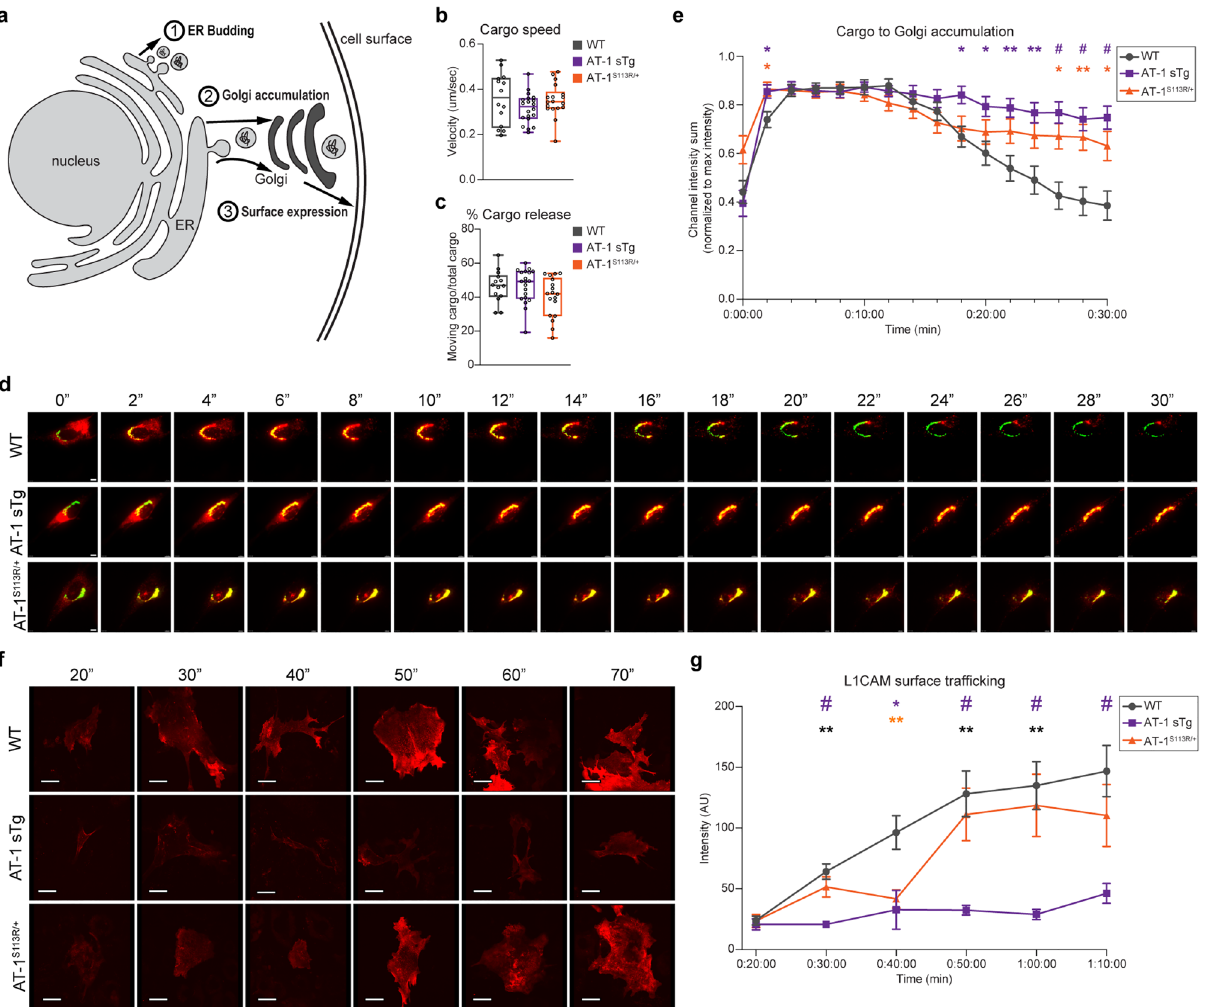
Figure 3. Aberrant AT-1 models demonstrate altered protein trafficking through the secretory pathway. ( a ) Schematic of three experiments used to assess protein trafficking in the secretory pathway. Experiment 1 assesses protein-laden carriers following release from the ER; solubilizer-dependent cargo fluoresces for visualization. Experiment 2 quantifies the time for ER cargo to accumulate in the Golgi apparatus and then egress; solubilizer-dependent DsRed cargo traffics to GFP-labeled Golgi. Experiment 3 quantifies the time for ER cargo to reach the cell surface; solubilizer-dependent cargo with a HaloTag ligand is tracked for 70 min with HaloTag cell impermeable dye added prior to imaging. ( b,c ) Maximum speed of cargo release ( b ), and the percentage of cargo release ( c ), are tracked for 3 min after solubilizer induced cargo release in MEFs (MEFs from multiple cells from 3 biologically independent animals for each genotype n = 14 WT; n = 20 AT-1 sTg; n = 18 AT-1 S113R/+ ; MEF cells from 3 biologically independent animals for each group for ( b , c ). Student’s T-test. ( d ) Representative cargo (red) accumulation in the Golgi (green) every 2 min, for 30 min in MEFs from WT, AT-1 sTg, and AT-1 S113R/+ (scale bar, 40 µm). ( e ) Cargo accumulation in the Golgi over 30 min in primary- cultured MEFs (MEFs from multiple cells from 3 biologically independent animals for each genotype at each time point, n = 27 WT; n = 22 AT-1 sTg; n = 23 AT-1 S113R/+ ). Mean with SEM are represented at each time point. ( f ) Representative surface trafficking of L1CAM in MEFs from WT, AT-1 sTg, and AT-1 S113R/+ (scale bar, 40 µm). ( g ) L1CAM intensity at the cell surface in MEFs (MEFs from multiple cells from 3 biologically independent animals for each genotype at each time point, n = 42–76 WT; n = 10–27 AT-1 sTg; n = 19–34 AT-1 S113R/+ ). Mean with SEM are represented at each time point. Two-way ANOVA with multiple comparisons at each time point for ( e , g ). Purple and orange statistics indicate differences between AT-1 sTg and WT, and between AT-1 S113R/+ and WT, respectively. Grey statistics indicate difference between AT-1 sTg and AT-1 S113R/+ . *P < 0.05; **P < 0.005; # P <